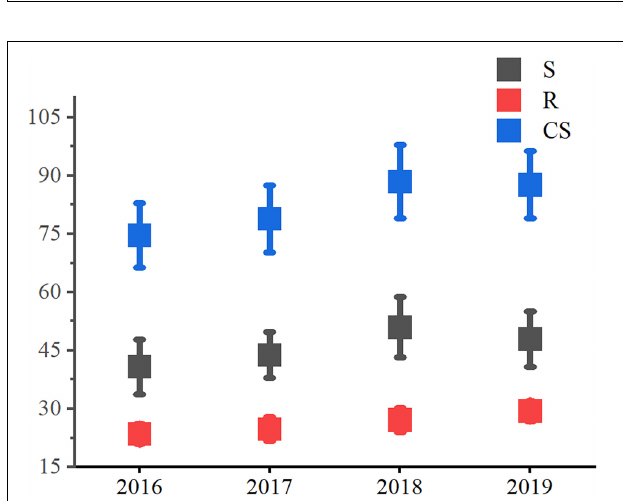
FIGURE 12 | Uncertainty analyses of assessment of four wetlands. “a”: Haihu wetland. “b”:Huoshaogou wetland. “c”: Beichuan wetland. “d”: Ninghu wetland. “e”: Huangshuihe wetland. “S”: Average score of state indexes. “R”: Average score of response indexes. “Cs”: Average score of comprehensive health